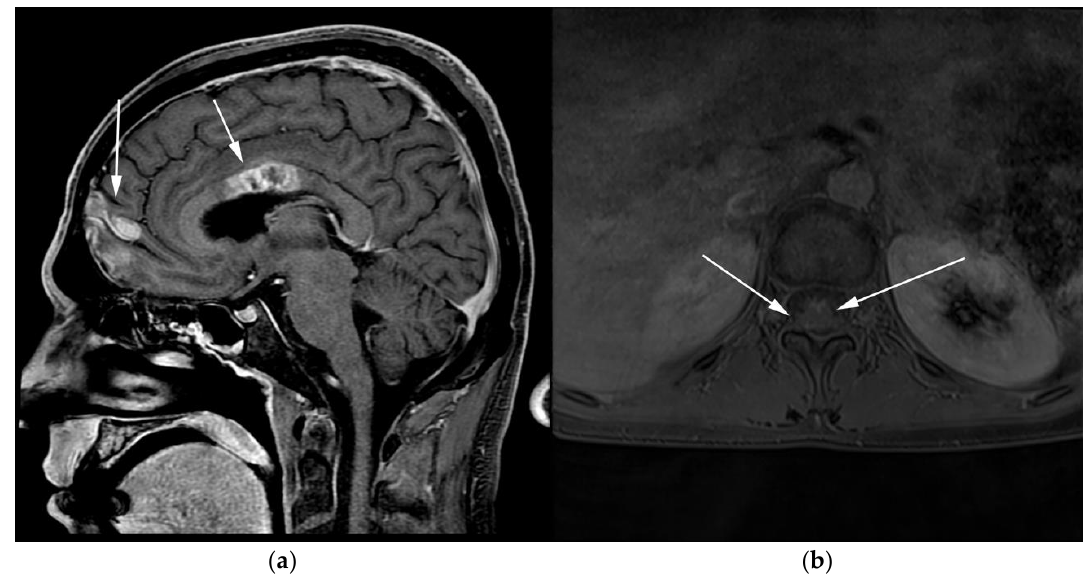
Figure 10. Imaging in the same patient 1 year later — patient developed new brain and spine lesions. ( a ) Sagittal T1 post-contrast MRI images show heterogenous mass within the body of the corpus callosum (posterior arrows) as well as within the frontal cortex (anterior arrows). ( b ) Axial T1 post-contrast MRI of the spine shows ill-defined enhancement within the spinal cord (arrows), consistent with leptomeningeal disease.